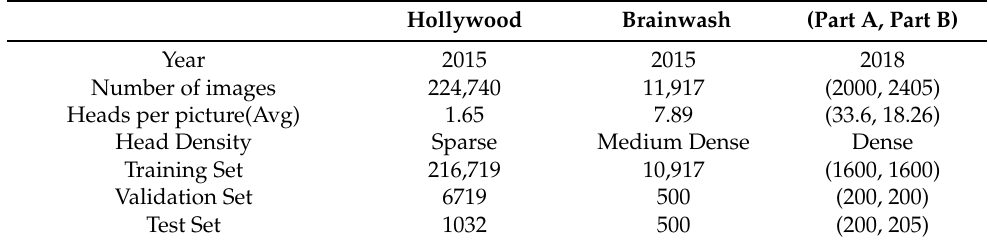
Table 4. Comparison of the three head